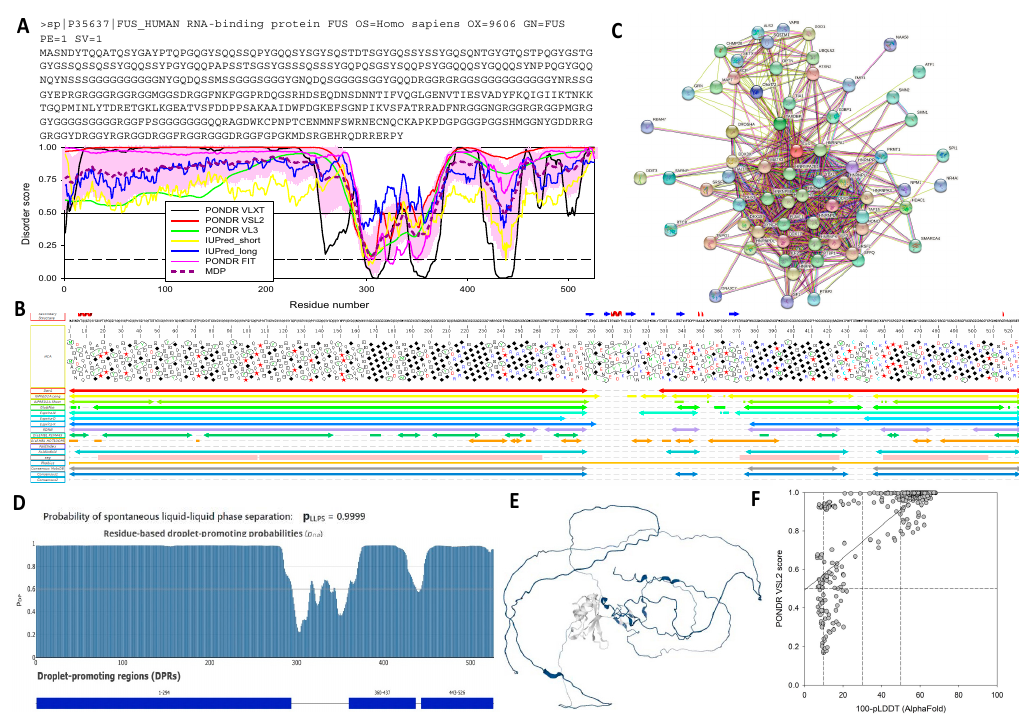
Figure 3. Functional disorder in RNA-binding protein FUS. ( A ). Amino acid sequence (top) and RIDAO-generated disorder profile (bottom). RIDAO aggregates the results from a number of well-known disorder predictors: PONDR ® VLXT (black line), PONDR ® VLS2 (red line), PONDR ® VL3 (green line), IUPred2_short (yellow line), IUPred2_long (blue line), and PONDR ® FIT (pink line). Mean disorder prediction (MDP), which is calculated by averaging the outputs of these six predictors, is shown by a thick dashed dark-pink line and the corresponding error distribution is shown by a light pink shadow. The outputs of the evaluation of the per residue disorder propensity by these tools are represented as real numbers between 0 (ideal prediction of order) and 1 (ideal prediction of disorder). A threshold of ≥ 0.5 is used to identify disordered residues and regions in query proteins. Solid and dashed horizontal lines at disorder scores 0.5 and 0.15 correspond to the disorder and flexibility thresholds. ( B ). MeDor output. MeDor aggregates the results of eight predictors implemented in MobiDB-lite 3.0 (GlobPlot, ESpritz-N, ESpritz-D, ESpritz-X, IUPRED2A Long, IUPRED2A Short, DisEMBL REM465, DisEMBL hot- loops) along with those provided by DorA, MoreRONN (RONN), FoldIndex, and FoldUnfold. Regions predicted to be disordered by the various predictors are indicated by double arrows with a color code corresponding to that of the corresponding predictors as indicated on the left, while regions predicted to be ordered are shown as grey dashed lines. The MeDor output displays the MobiDB-lite consen- sus (Consensus MobiDB, grey double arrow) and two other types of global consensus: Consensus 1 (dark blue double arrow), which corresponds to regions predicted to be disordered by more than half of the implemented predictors, and Consensus 2, which corresponds to regions consistently predicted to be disordered by all the implemented predictors (none in this case). The MeDor output also displays low-complexity regions (pink bar) and transmembrane regions (none in this case). The HCA plot (see Appendix A) is shown below the amino acid sequence. Predicted α -helices (red) and β -strands (blue arrows) are shown above the sequence. ( C ). STRING-generated PPI network. The minimum required interaction score was set to 0.700 (high confidence). Number of nodes 67; number of edges 523; average node degree: 15.6; avg. local clustering coefficient: 0.77; expected number of edges: 97; PPI enrichment p -value: < 1.0 × 10 − 16 . The corresponding interactive map of FUS-centered PPI network can be found at: https://string-db.org/cgi/network?taskId=bvsmgavPysJb&sessionId=bxLUgl7X6fKS (last accessed on 2 January 2023). ( D ). FuzDrop output. ( E ). AlphaFold2 structure with FuzDrop annotations. ( F ). Per residue correlation plot of disorder score (as provided by PONDR VLS2) versus (100-pLDDT), where pLDDT is the corresponding AlphaFold2 confidence